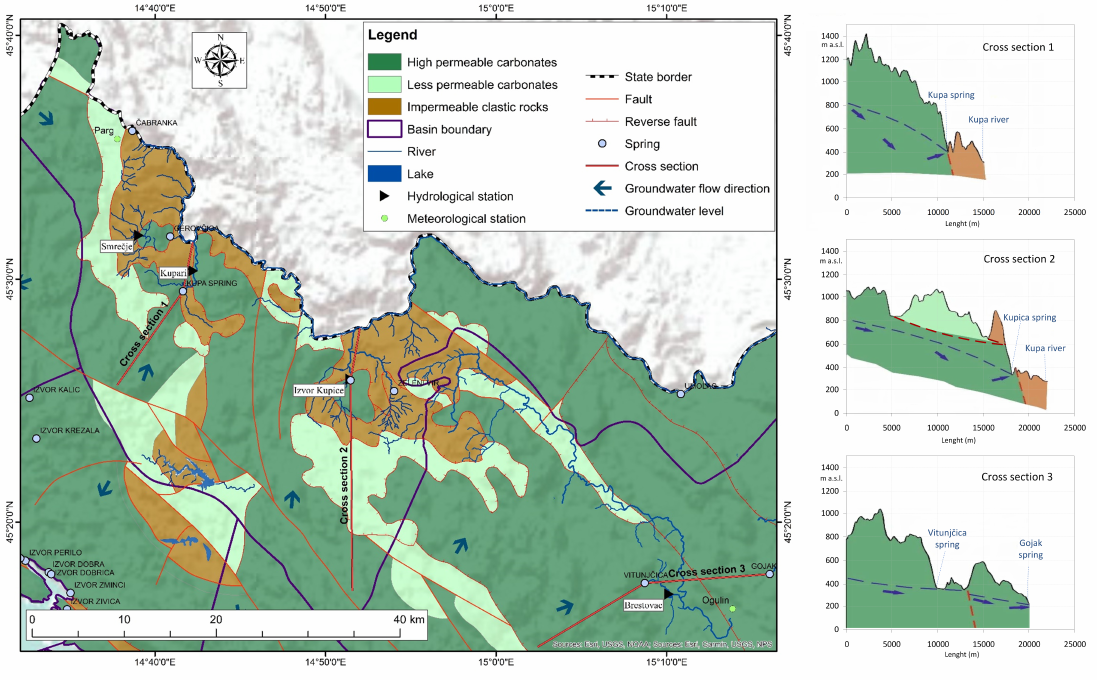
Figure 2. Schematic permeability map of research area and characteristic cross-sections (according to